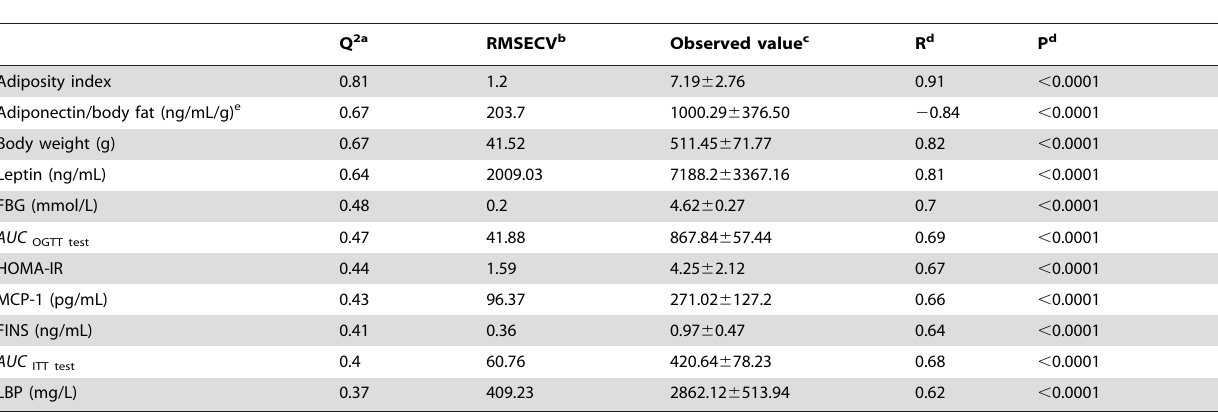
Table 1. Prediction of host phenotypes using the RDA-identified key OTUs with PLS regression